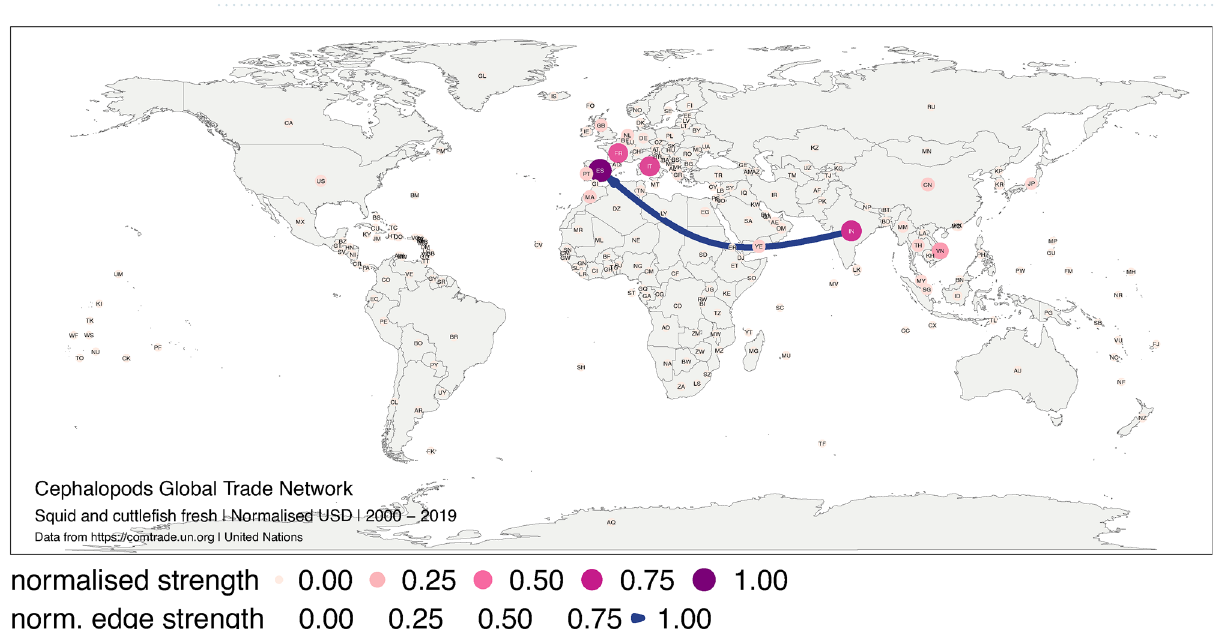
Figure 6. Global trade network for squid and cuttlefish live, fresh or chilled between 1 January 2000, and 31 December 2019 in monetary value (USD). The numbers correspond to the normalised strength for the monetary value. Each node represents a trader, and each edge represents the export–import relationship between two traders. The size and colour of the node represent the relative importance of the trader in the network in terms of its strength. The width and colour of the edge represent the relative importance of the relationship between two traders in terms of their edge strength. The figure was created with R 12 (https:// cran.r- proje ct. org) packages: “ggplot2” v.3.2.1 13 (https:// ggplo t2. tidyv erse. org), “ggmap” v.3.0.0 29 (https:// github. com/ dkahle/ ggmap) and “ggraph” v.2.0.0 30 (https:// ggraph. data- imagi nist.